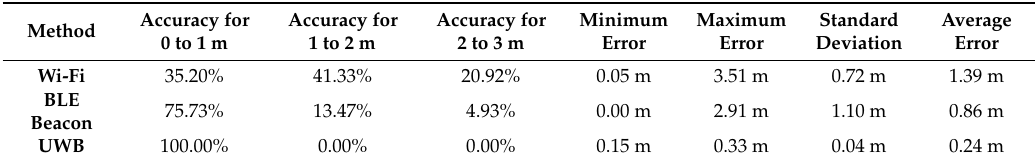
Table 3. Comparison of accuracy results.